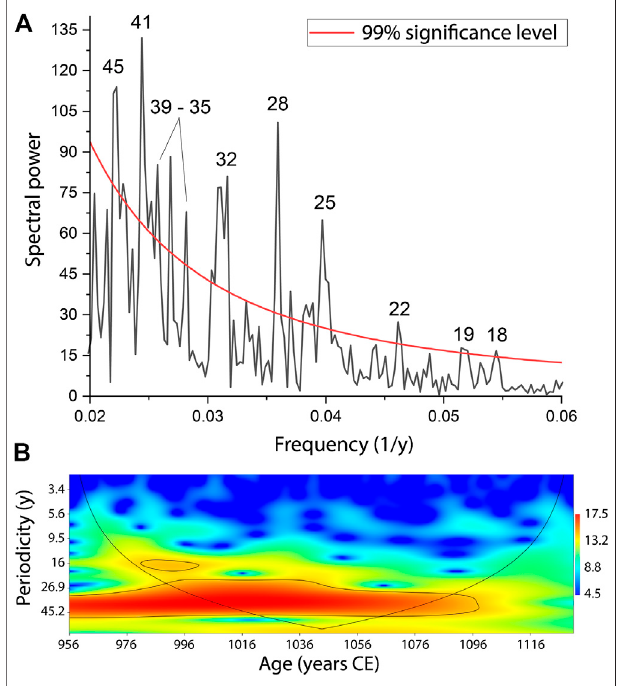
FIGURE 8 | Spectral analysis of the magnetic fi eld time series. (A) Spectral analysis (REDFIT) performed on the magnetic time series (in units of μ T and with equally spaced 0.25 years intervals) using the software PAST2 (Hammer et al., 2001). The parameters used were: window : rectangle; oversample : 2; segment : 5. The red line represents the 99% χ 2 con fi dence level.The number above the picks indicates theperiodicity values in years. (B) Wavelet analysis performed on the magnetic fi eld time series using the software PAST and the Morlet mother wavelet (Torrence and Compton, 1998). Black lines indicate the 95% signi fi cance level and the cone of in fl uence, inside of which the record is of suf fi cient length to interpret